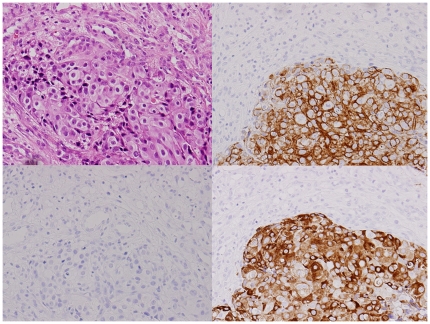
An adenocarcinoma showing typical presentation of the breast profile by immunohistochemistry.Hematoxylin-eosin stain (left upper), cytokeratin (CK)7 (right upper), CK20 (left lower), and mammaglobin (right lower). CK7 and mammaglobin are positive in the cytoplasm of tumor cells (original magnification ×200).